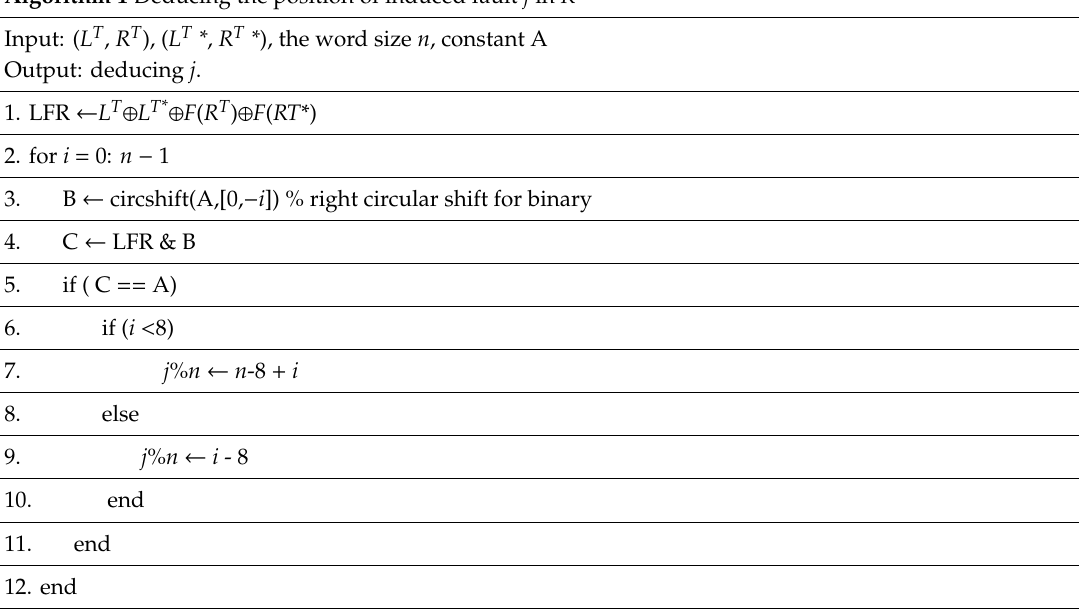
Algorithm 1 Deducing the position of induced fault j in K T −